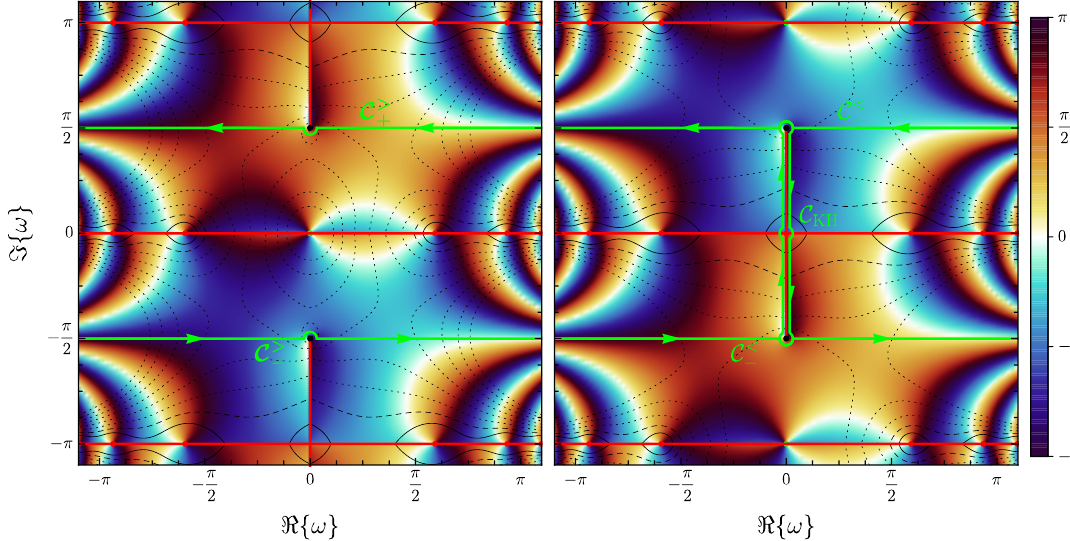
Figure 2: Complex structure of the contour integrands in the hyperbolic ω -plane + x ) / ( 2 Γ )] in the unordered phase (left, x > 0, for the odd sum over ln [( Γ δ m m (2.25)) and in the ordered phase (right, x δ < 0, (2.27)), together with the corre- sponding contours C ≷ . The complex phase is colour coded from − π to π , while the lines of constant absolute value c are shown as black dotted ( c < 1), dashed ( c = 1) or solid ( c > 1) lines, where c are consecutive integer powers of two. Zeros (Poles) are marked as green (red) dots. Going from one to the other phase leads to a shift of one half-period of the functions along the imaginary axis, thus the contour + C < + C C < = C < of the ordered phase is basically the reverse of the unordered + − KH + C > phase C > = C > plus the additional keyhole contour C around the logarithmic + − KH branch cut at [ i π/ 2,3i π/ 2 ] (left) or at [ − i π/ 2, + i π/ 2 ] (right). Additionally the con- tours need to evade the branch points at ω = i n π/ 2 with n ∈ (cid:90) . Note that there is a phase jump along the real axis and between every half-period due to the switching between the two counting kernels K ± , shown as red o